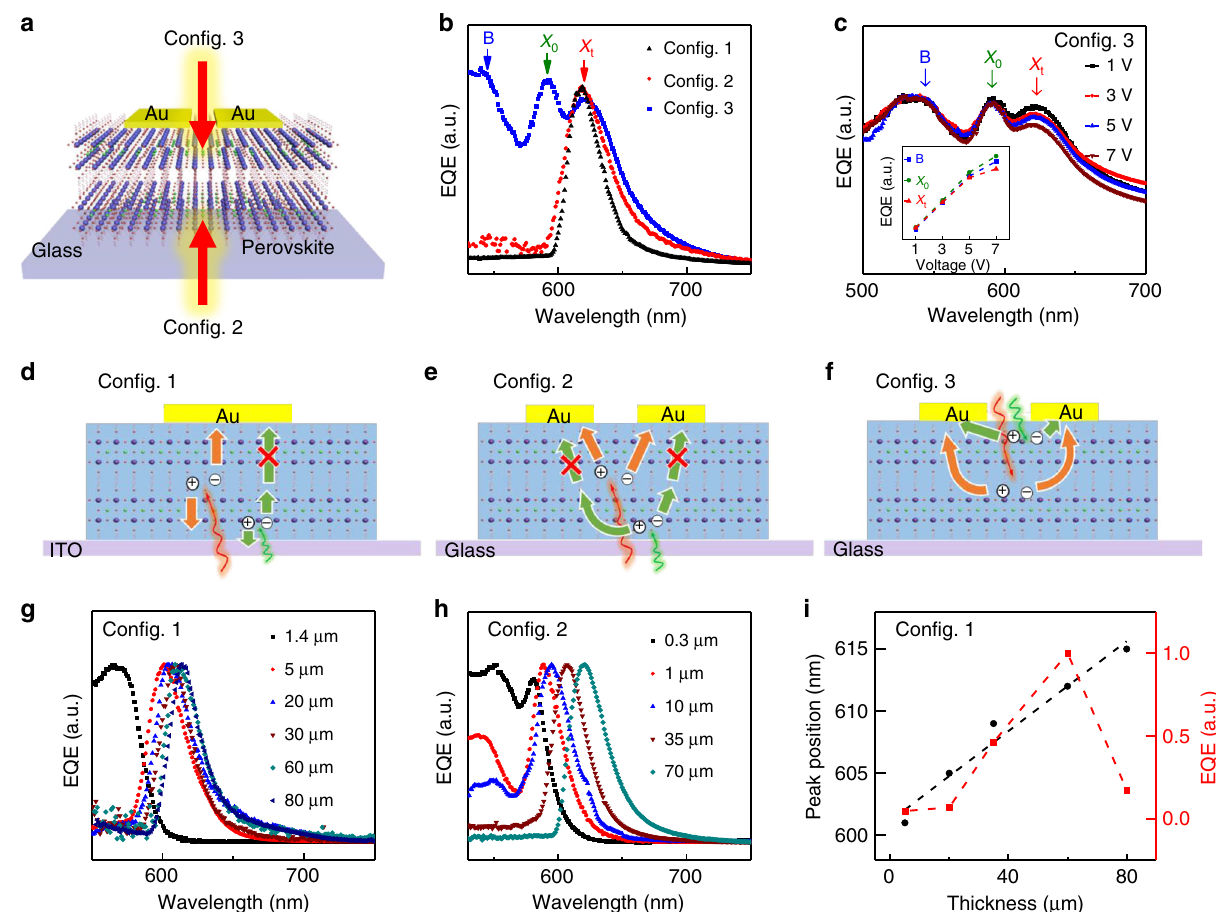
Fig. 4 Mechanism study of the 2D perovskite based narrowband photodetection. a Schematic of the 2D perovskite single crystal-based lateral device with illumination from back side (Con fi g. 2) and front side (Con fi g. 3). b Normalized EQE spectra of the (BA) 2 (MA)Pb 2 I 7 devices with three different measurement con fi gurations. The peaks of the spectra are marked by arrows with different color. Blue arrow: band-to-band ( B ); green arrow: free exciton ( X 0 ); red arrow: self-trapped state ( X t ). c Normalized EQE spectra of device with Con fi g. 3 under different biases. Inset: the dependence of the EQE value of B peak, X X 0 peak, and t peak on bias. The dashed lines are used to guide the eye. d , e , f Schematic of the carrier generation and extraction process for the above mentioned three different measurement con fi gurations. Red: long wavelength light and bulk-generated carriers. Green: short-wavelength light and surface-generated carriers. g , h The thickness dependence of normalized EQE spectra of the (BA) 2 (MA)Pb 2 I 7 devices for Con fi g. 1 ( g ) and Con fi g. 2 ( f ), respectively. i Thickness dependence of peak position under the same applied electrical bias and normalized EQE under the same applied electrical fi eld extracted from the EQE spectra in g . The dashed lines are used to guide the